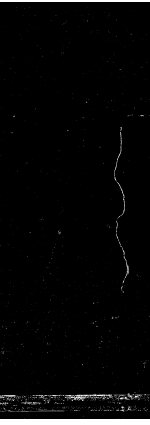
Figure 7. Image differencing using Gaussian valley emphasis for automatic